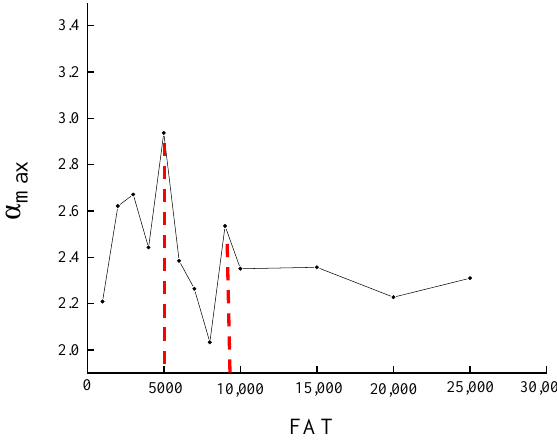
Figure 8. The change of α max vs. FAT (Hubei Province) . Table 7. Calculated parameters of the multifractal method (Hubei Province).